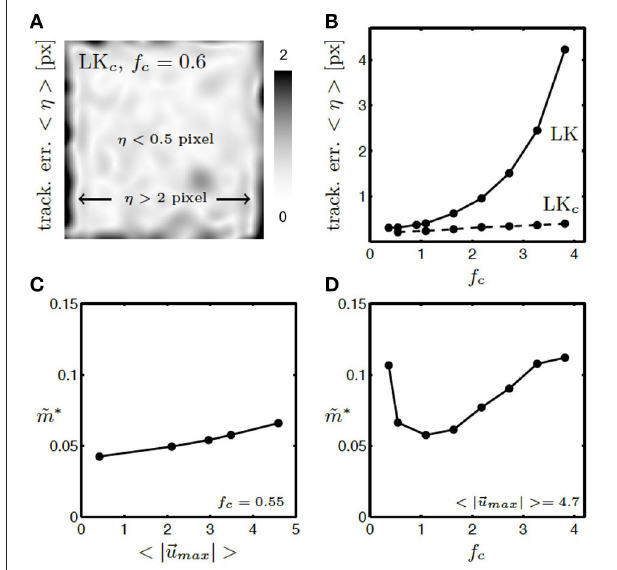
FIGURE 12 | Tracking error η and residual motion artifacts ˜ m ∗ in synthetic, tracked and motion-stabilized optical maps with various amplitudes of motion and relative signal strengths. (A) Tracking error η within video image averaged over all video frames with contrast-enhancement ( LK c ). Within the video image errors are acceptable ( < 0.5 pixel), toward the boundaries errors can become large ( η > 2 pixel). Video image is 100 × 100 pixel in size. See also Supplementary Video 4 . (B) Tracking error η with ( LK c ) and without ( LK ) contrast-enhancement. Tracking error grows exponentially with increasing signal-to-contrast ratio f c without image contrast-enhancement (LK) and remains small with image contrast-enhancement ( LK c ) for all signal-to-contrast ratios f c . (C) Residual motion artifacts ˜ m ∗ are equally small (cf. Figure 10E ) for small and large amplitudes of motion in the original videos. (D) Residual motion artifacts ˜ m ∗ are minimal for relative signal strengths in the range of f c = 0.5 − 2.0 or when f ≈ c